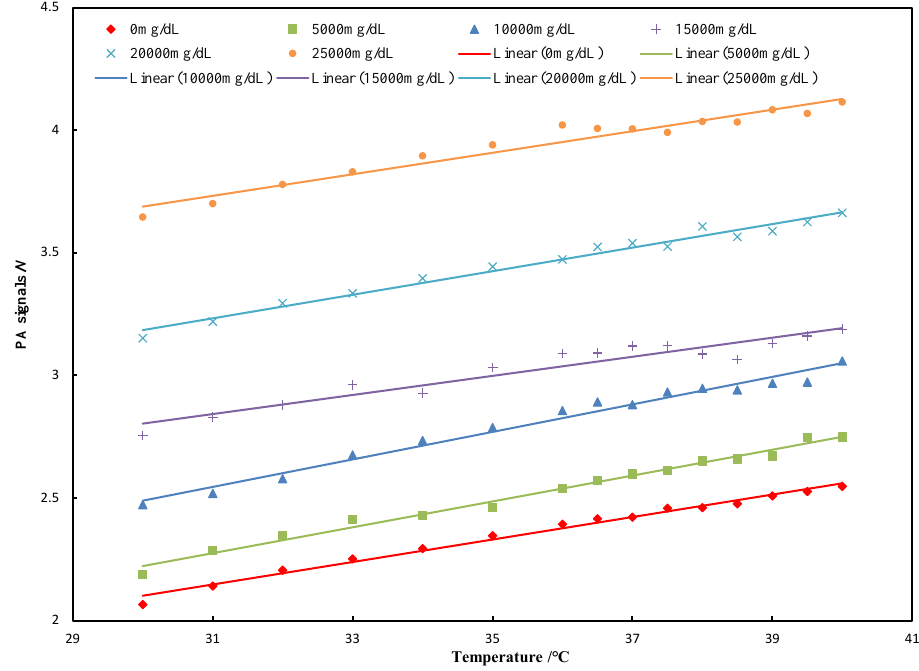
Figure 5. Relation of the PA signals to temperature under different